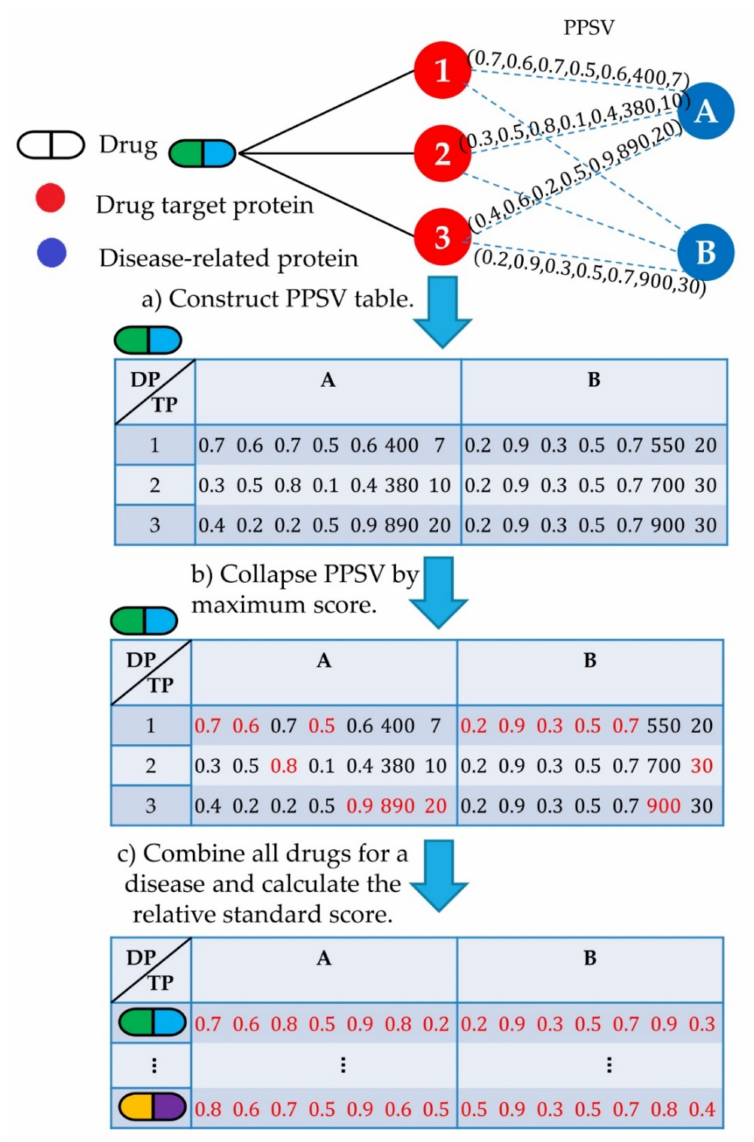
Figure 3. Construction of the drug–disease matrix for a disease. ( a ) Construct a PPSV table, ( b ) collapse PPSV using the maximum score, ( c ) combine all drugs for a disease and calculate the relative standard